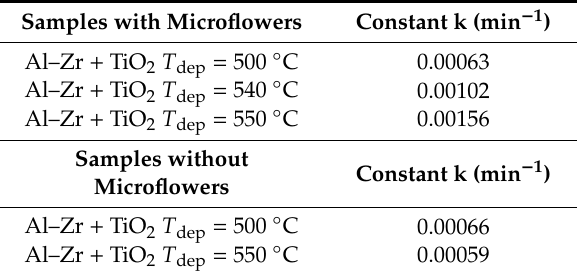
Table 2. The effect of presence of microflowers on the decomposition rate and the crystal size for the TiO 2 /Al–Zr coatings deposited at 500 °C and 550 °C.